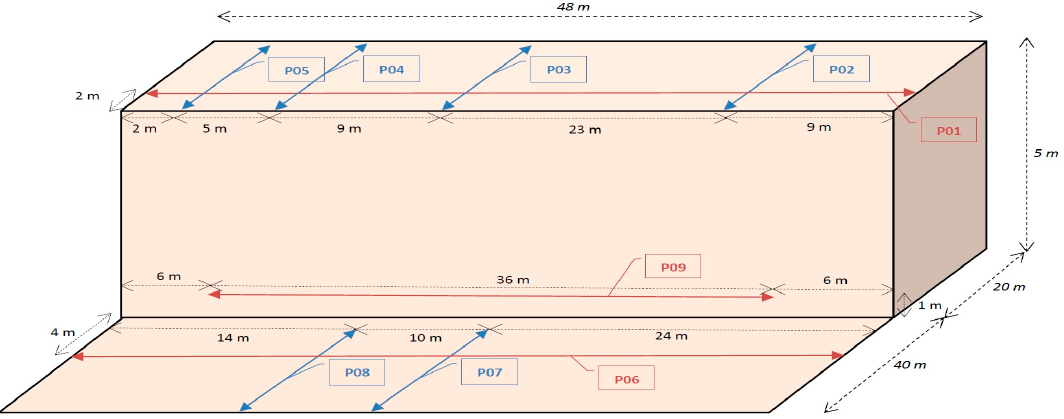
Figure 5. Schematic showing the locations of the GPR profiles.